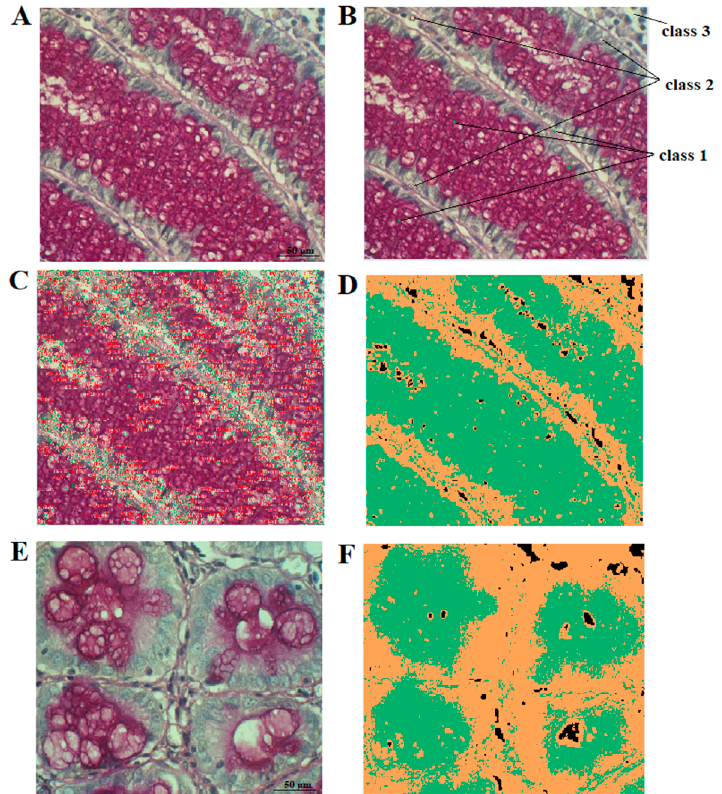
Figure 7. Typical steps for digital image analysis by using Image-Pro Premier software concerning expression of PAS + mucins in control colon ( A ) and colorectal cancer tissue samples ( E ). Raw image ( A ); smart segmentation to identify PAS + reaction—class 1, tissue area without reaction—class 2, background—class 3 ( B ); classification of structures ( C ); final PAS reaction image with mask applied (green color—PAS reaction, yellow—remaining tissue, black—background) ( D , F ).